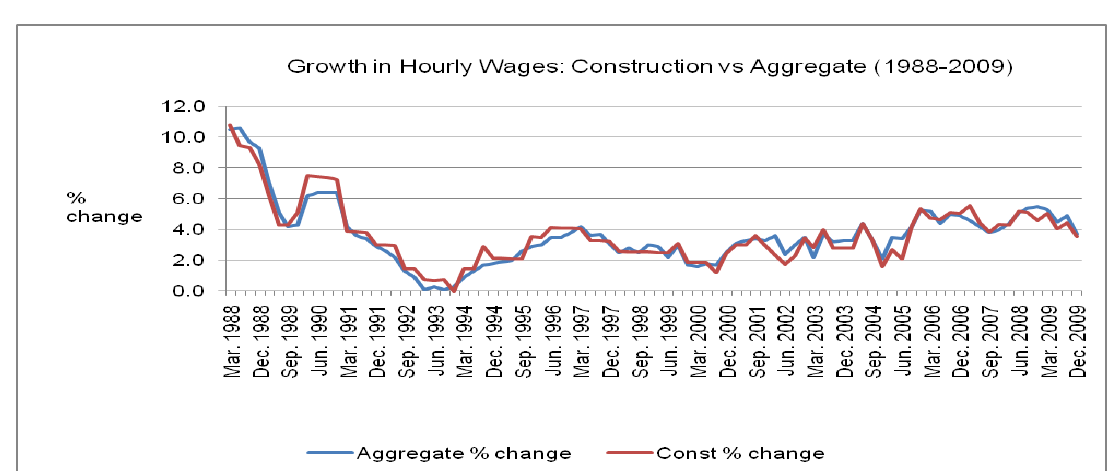
Figure 7 Average Hourly Earnings